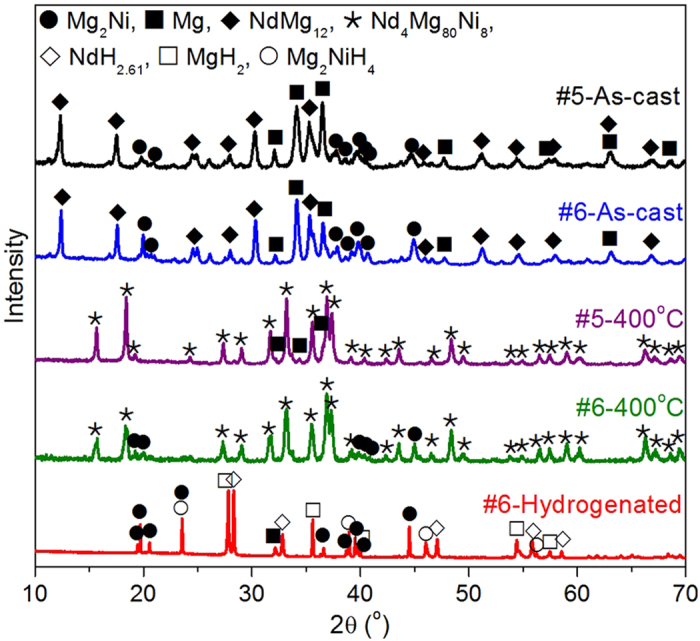
The XRD patterns of Nd4Mg80Ni8 with different heat treatment conditions.